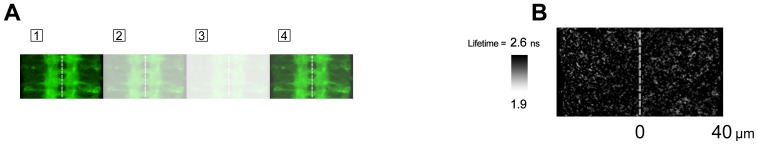
Lifetime quantification.A. mEGFP emission is collected at four phase-shifted points. B. Mean fluorescence lifetime in a CNS segment examined (see A).